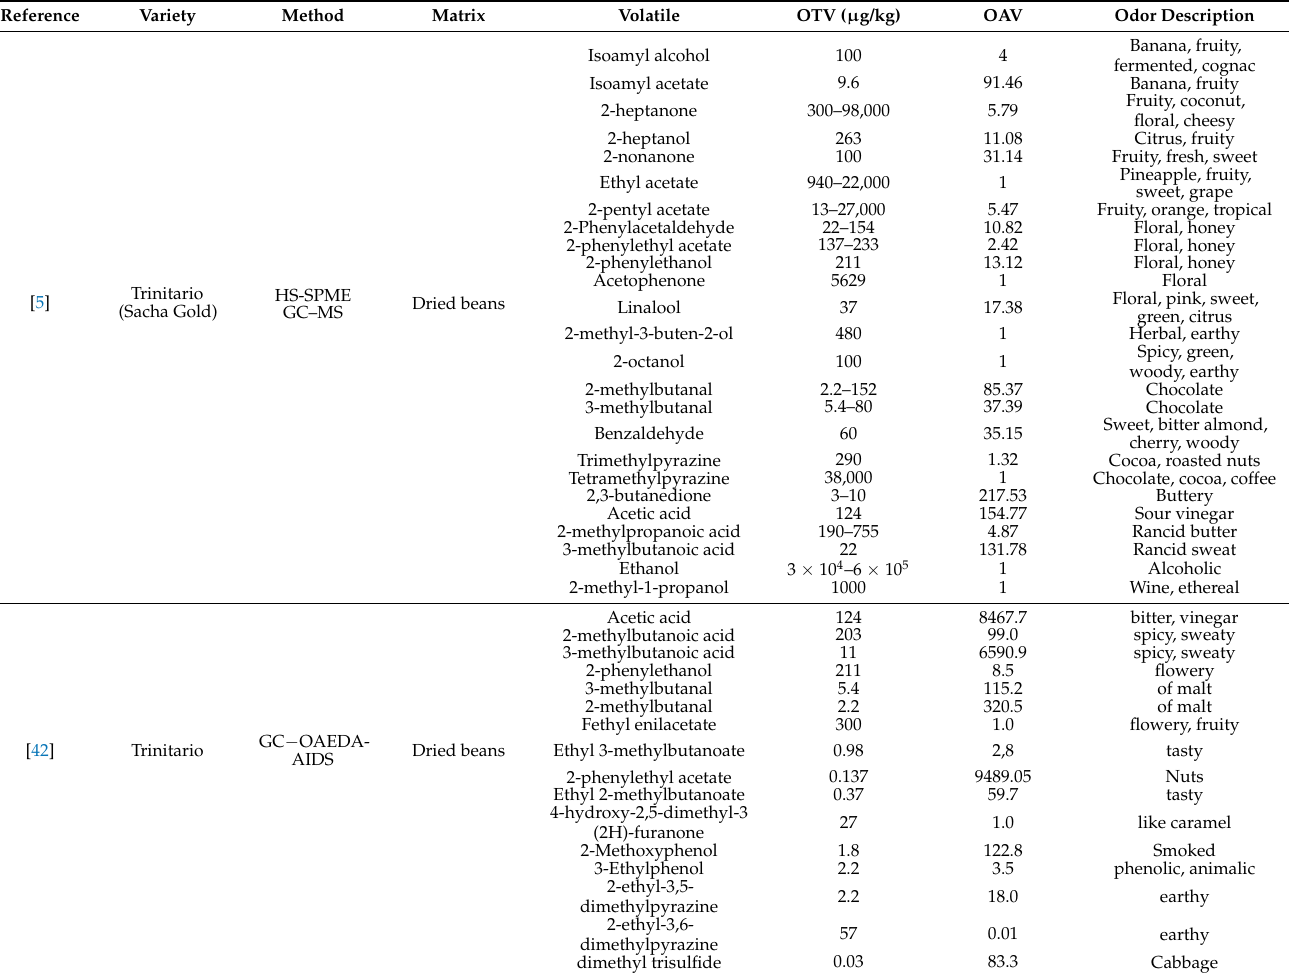
Table 3. Odor activity values of key aroma compounds in fermented dried